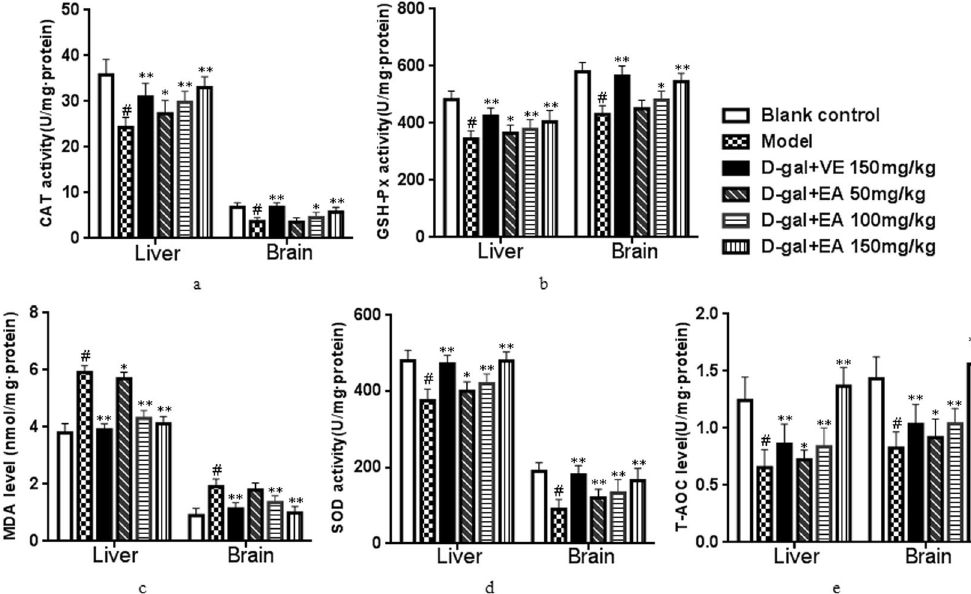
Figure 2. Effects of EA on the activities of CAT ( a ), GSH-Px ( b ), MDA ( c ), SOD ( d ) and T-AOC(e) in rats. Date are presented as mean ± SD from each group(n = 8). # P < 0.01 vs blank control group. ** P < 0.01 and * P < 0.05 vs D-gal model